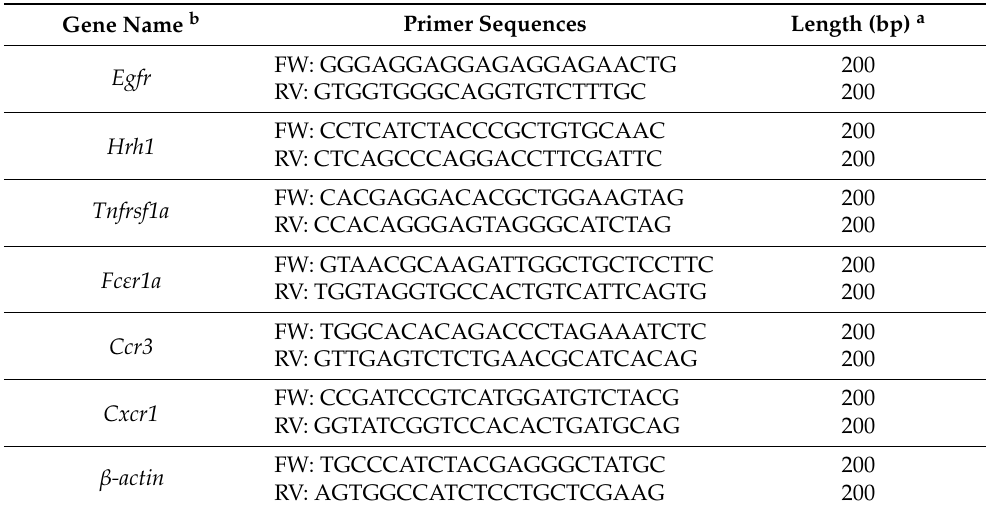
Table 9. Primer sequences used for detection of receptors related to allergic inflammation and a house-keeping gene β -actin using real time qPCR